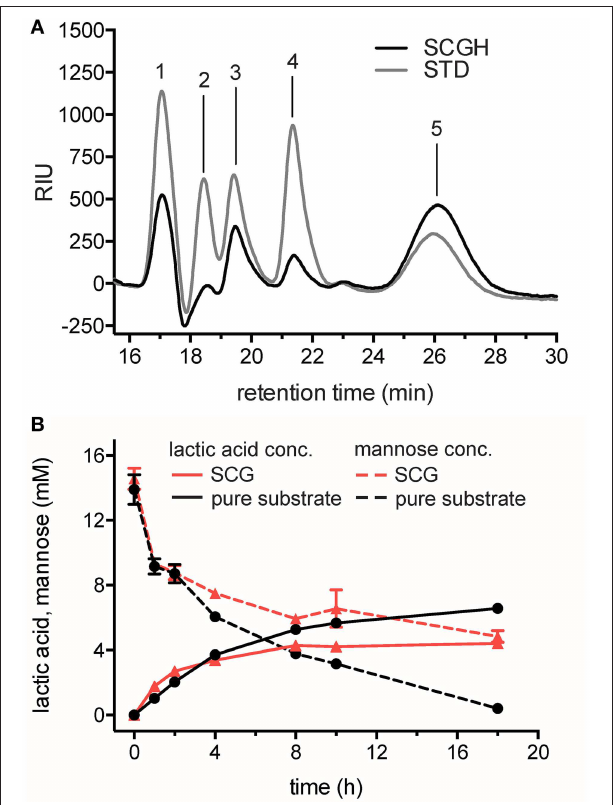
FIGURE 3 | Hydrolysis of SCG and its conversion into LA using the cell-free reaction cascade. (A) Analysis of monosaccharides after dilute acid hydrolysis of SCG. STD, sugar reducing standards (gray line); SCGH, spent coffee grounds hydrolysate (black line). Retention times of standards are indicated. 1: D-glucose 2: D-xylose 3: D-galactose 4: L-arabinose 5: D-mannose. (B) Production of LA from mannose obtained from SCG (red lines) compared to production from pure mannose (black lines) in time-course experiments. Decrease of mannose (dashed lines) and increase of LA (solid lines) were monitored by HPLC-RID and -DAD analysis and quantified by mannose and L-lactic acid standards. Reactions from SCG hydrolysate and from pure mannose as a substrate contained 14.57 ± 0.7mM and 13.9 ± 0.9mM mannose, respectively, 3.75mM NAD + , 0.1mM CoSO 4 , and standard enzyme loading in 0.1M NaP buffer pH 7.0. Reactions were performed in triplicate at 50 ◦ C. Error bars represent standard deviation of the